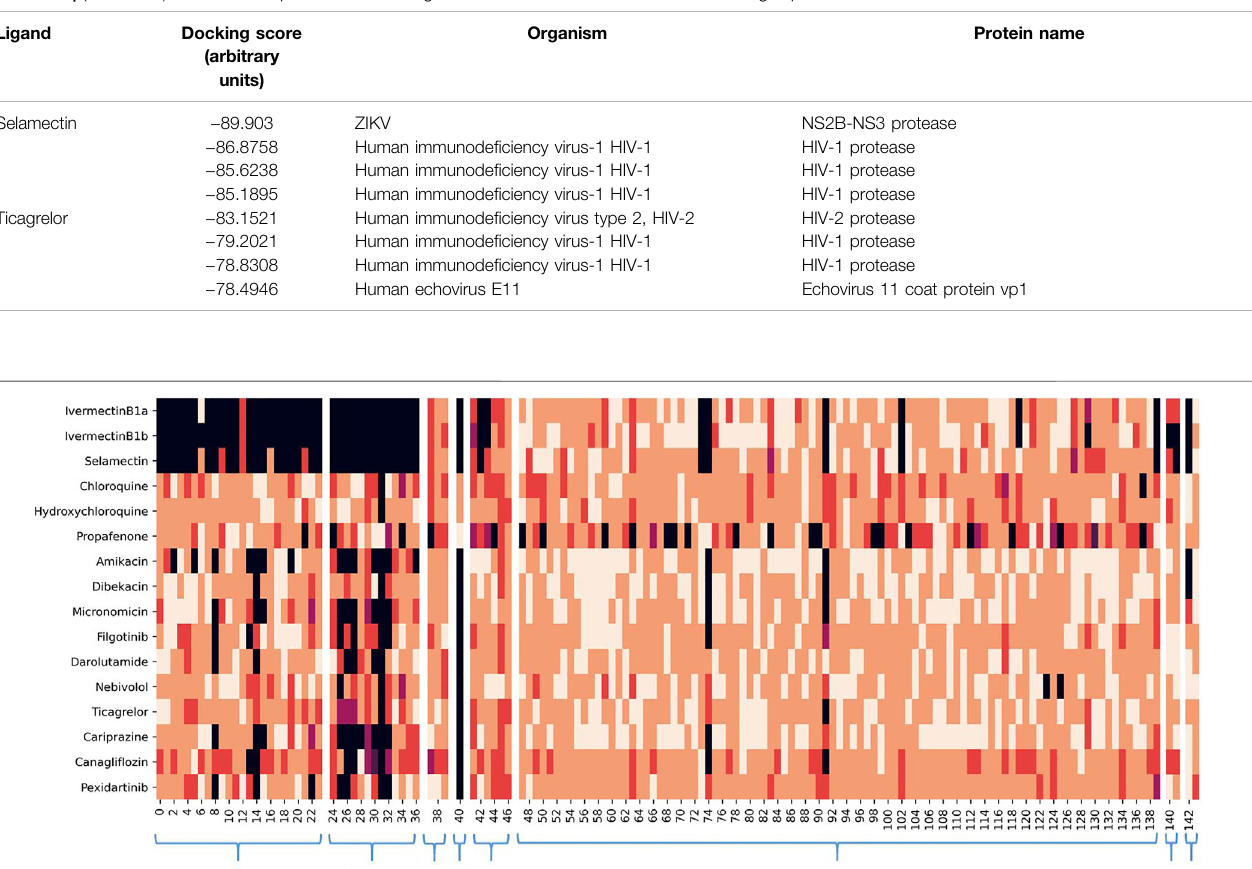
TABLE 3 | ( Continued ) Identi fi ed viral proteins with the highest scores in the inverse molecular docking